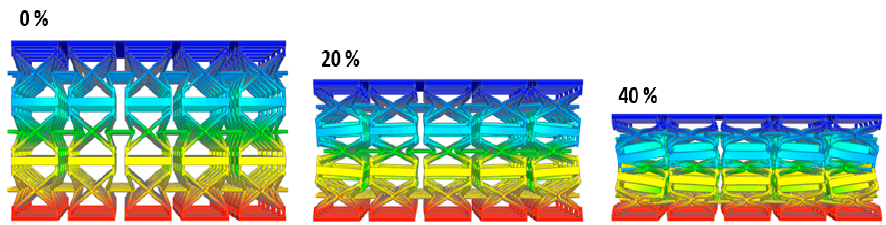
Figure 12. The numerical auxetic deformation modes of this novel structure at different strain regions in the vertical and horizontal directions.